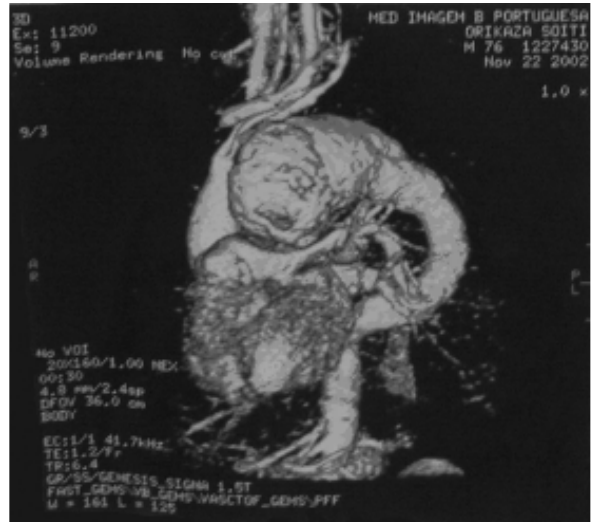
Fig. 2 - Angioressonância em 3D na primeira